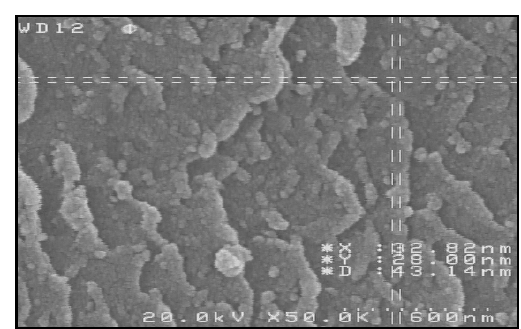
Fig. 2. The XRD patterns of (a) compound 1 prepared by reflux method, (b) nano-sized structure of compound